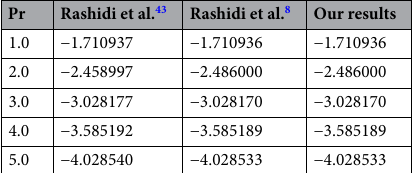
0 Nr Nc Q T Q E and = = = = =